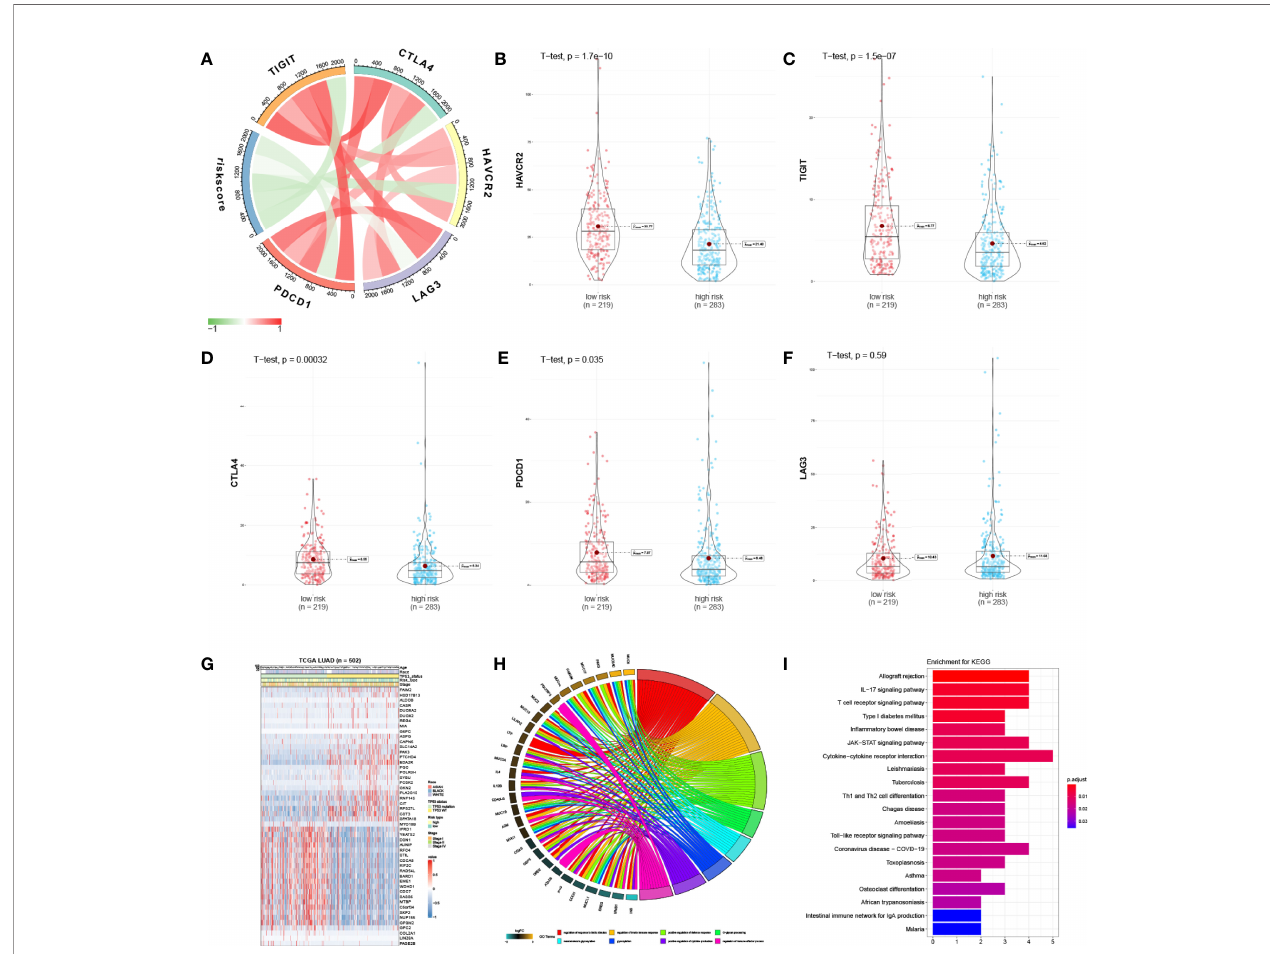
FIGURE 4 | Enrichment analysis of IPM. (A) Correlation of the IPM risk score with immune checkpoints ’ gene expression. (B) Violin plot of HAVCR2 between low- and high-risk groups. (C) Violin plot of TIGIT between low- and high-risk groups. (D) Violin plot of CTLA4 between low- and high-risk groups. (E) Violin plot of PDCD1 between low- and high-risk groups. (F) Violin plot of LAG3 between low- and high-risk groups. (G) Heatmap of signi fi cantly expressed immune genes between low* and high-risk groups. (H) Enriched biological processes of the immune genes. (I) Enriched KEGG pathways of the immune